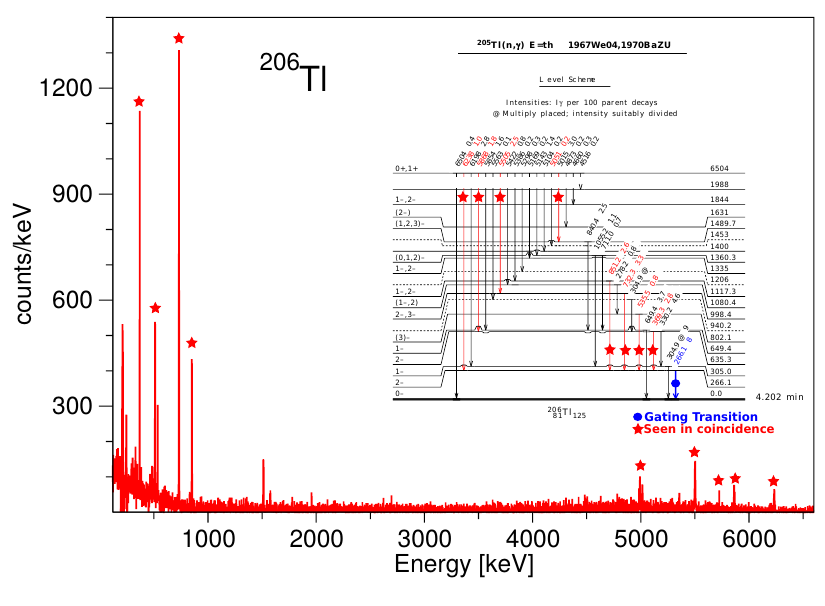
Figure 6: 205 Tl(n, γ ) 206 Tl: the very first γ -ray coincidence spectrum gated on the 266 keV 2 − transition ( 40 min statistics, the identified transitions are marked with red star symbols, a detailed ≈ analysis is